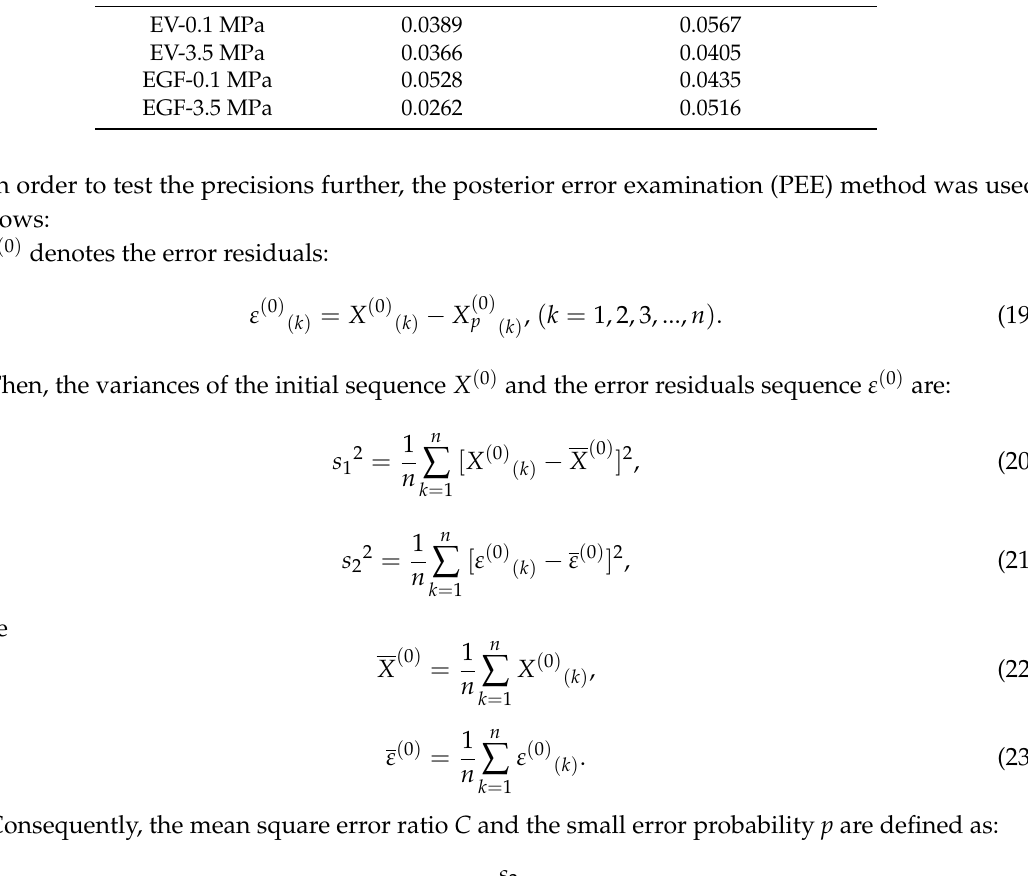
Figure 7. Log of adhesion- t fitted curves for the coatings under ordinary pressure and hydrostatic pressure. Table 4. The average relative errors of GM (1, 1) grey models and log of adhesion- t fitting method.